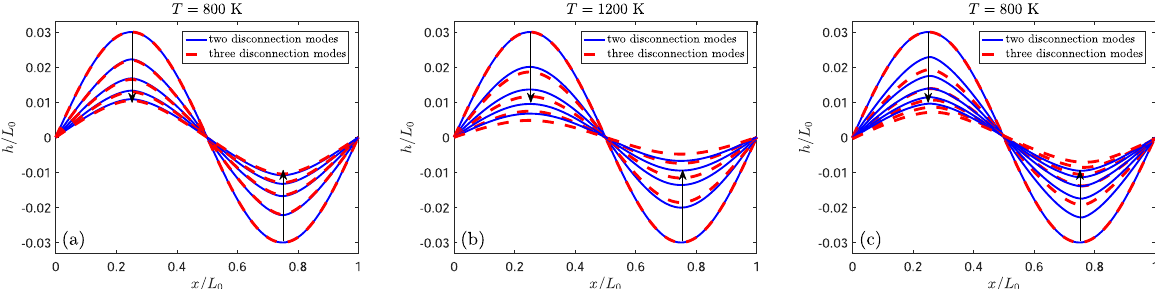
Fig. 5 Comparison of the GB evolution with different active disconnection modes. Comparison of the GB pro fi le evolution in the case of two and three disconnection modes. The arrows indicate the direction of the evolving curves. The three disconnections modes share the ffiffiffiffiffi p 26 , and H (1) = 4 b , H (2) = − 2.5 b , H (3) = − 9 b . The initial disconnection densities for the fi rst two modes are same Burgers vector b ð i Þ ¼ b ¼ a 0 = as per (19), while in the three mode calculations in a , b , we also set the initial values of ρ (3) = 0. In c , the initial disconnection densities are as per (15) and (16) with ρ (1) : ρ (2) : ρ (3) = 1: − 0.65: −